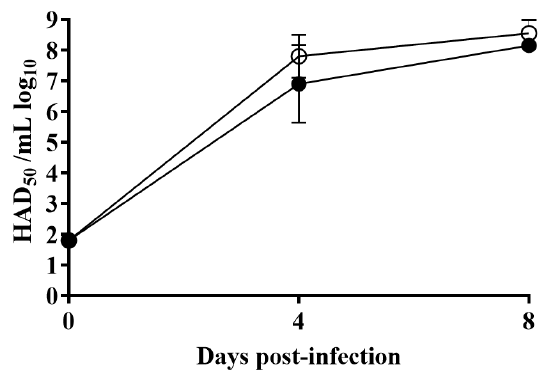
Figure 6. Viremia titers detected in pigs IM inoculated with 10 2 HAD 50 of either ASFV-G- ∆ X69R (filled symbols) or ASFV-G (empty symbols). Each curve represents the average and SD of animal values in each of the groups. Sensitivity of virus detection: >log 10 1.8 HAD 50 /mL.